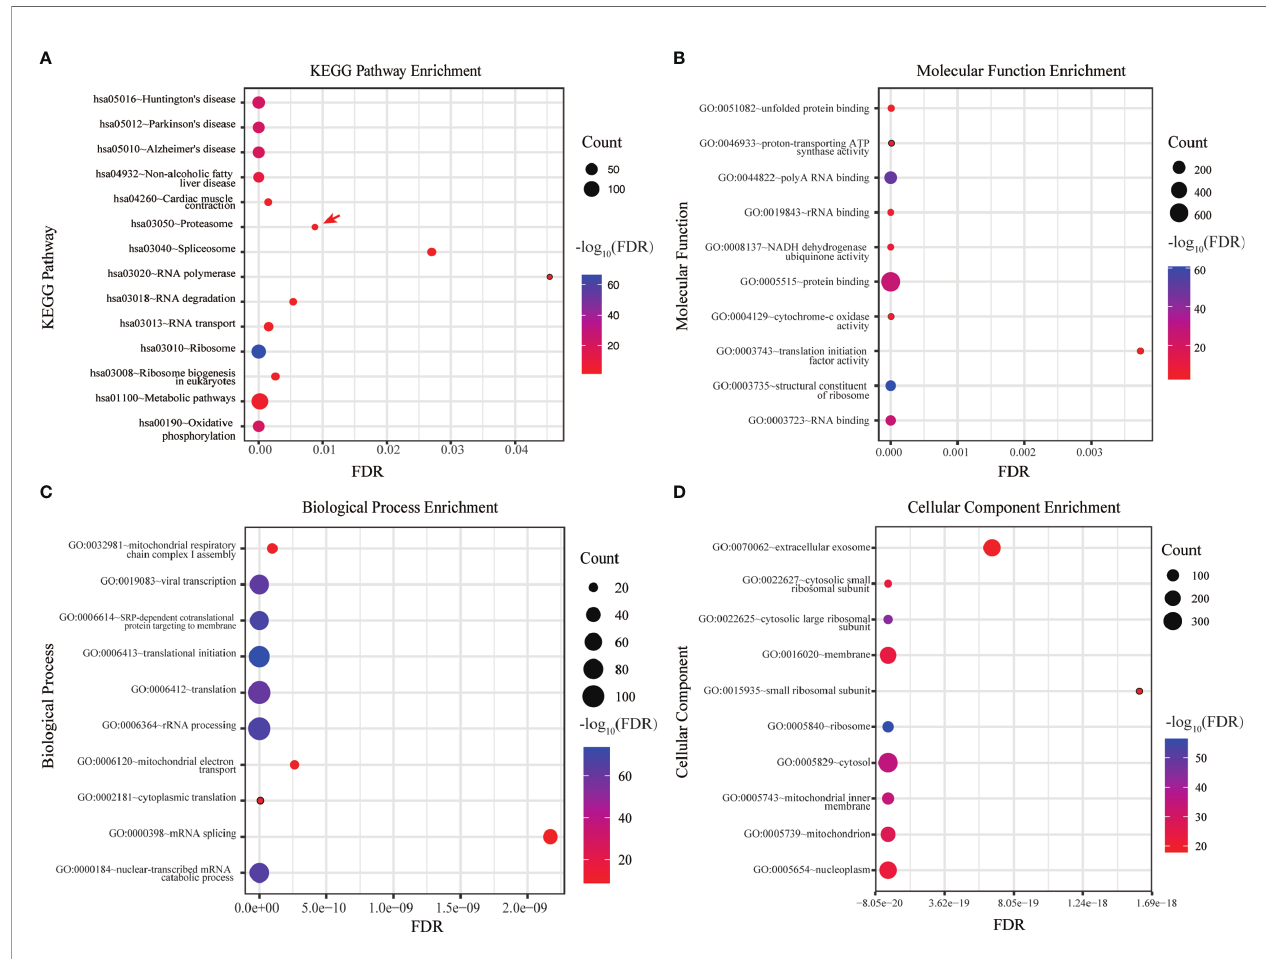
FIGURE 3 | Functional enrichment analysis of hub genes. (A) KEGG pathway enrichment analysis. (B) MF enrichment analysis. (C) BP enrichment analysis. (D) CC enrichment analysis.